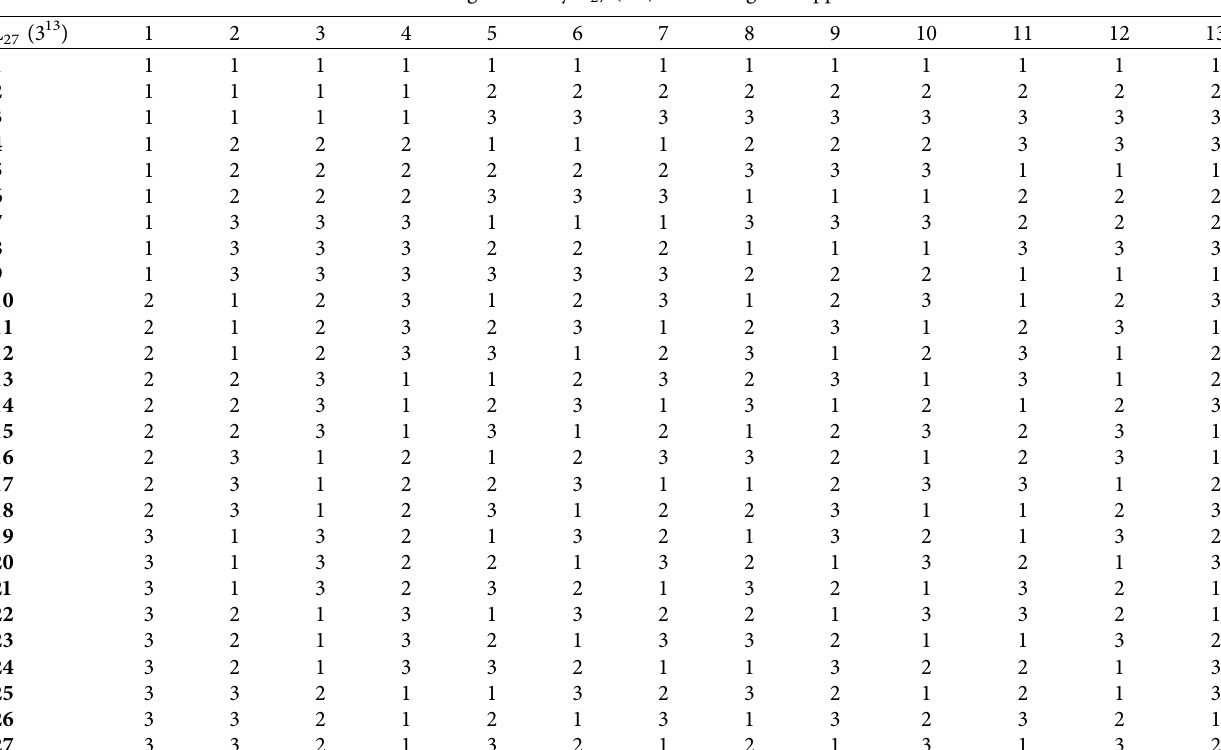
Table 4: Orthogonal array L